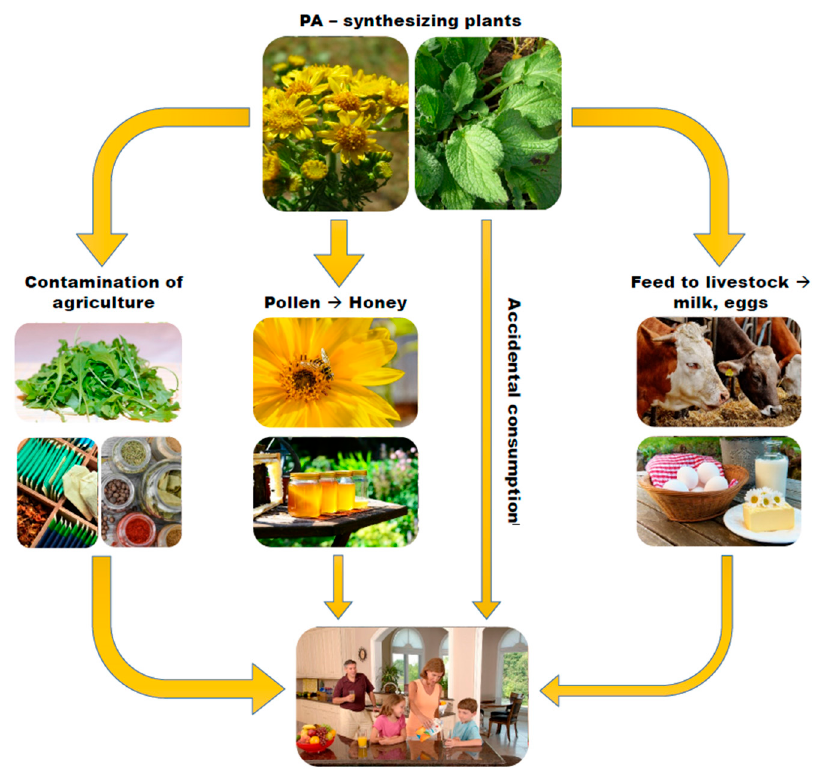
Figure 1. Four ways of how PA can enter the human food